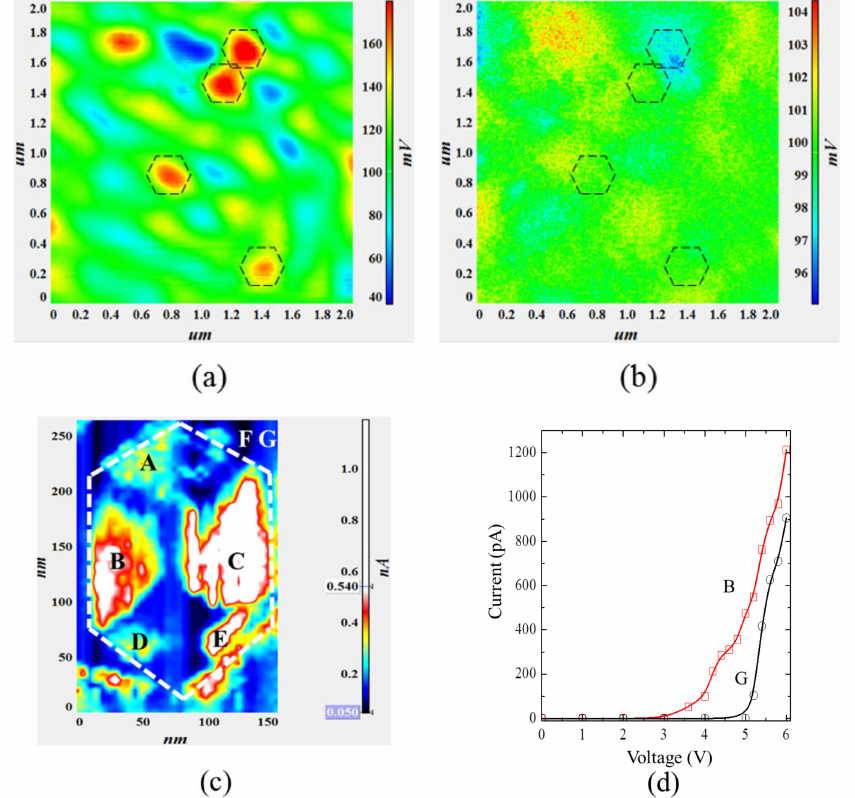
Figure 4. ( a ) near-field scanning optical microscopy-electroluminescence (NSOM-EL) and ( b ) near-field scanning optical microscopy photoluminescence (NSOM-PL) mapping for large V-defect sample in the scale of 2 × 2 µ m 2 , ( c ) conductive atomic force microscopy (CAFM) mapping around a large V-defect,